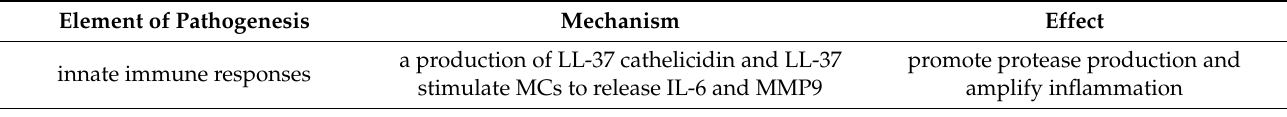
Table 3. The role of MCs in rosacea